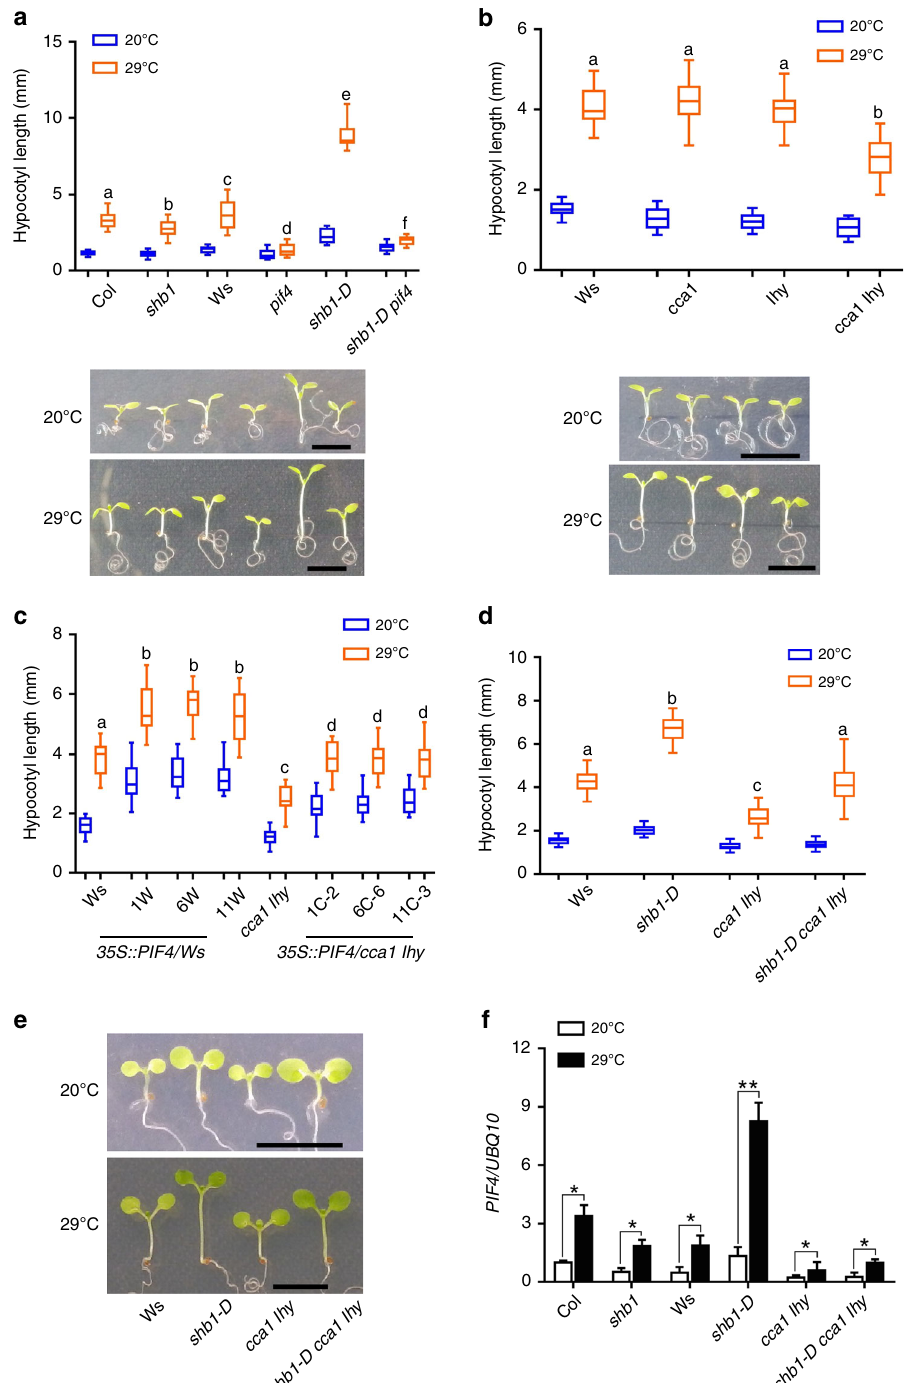
Fig. 3 CCA1/LHY and SHB1 enhance PIF4 expression and thermomorphogenesis. Hypocotyl lengths of Col, shb1 , Ws, pif4 , shb1-D , and shb1-D pif4 a ; Ws,